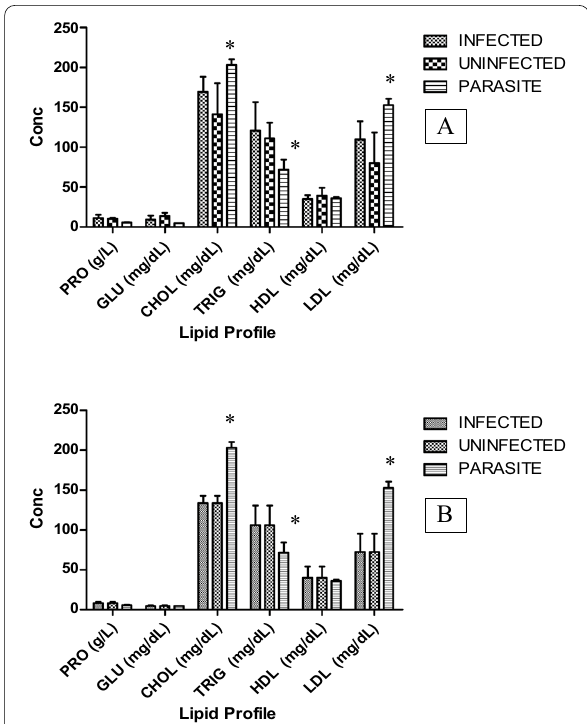
Fig. 2 Lipid profile in the liver ( A ) and intestine ( B ) of T. swinderianus . PRO protein, GLU glucose, CHOL cholesterol, = = = TRIG triglycerides, HDL high-density lipoproteins, = = LDL low-density lipoproteins =